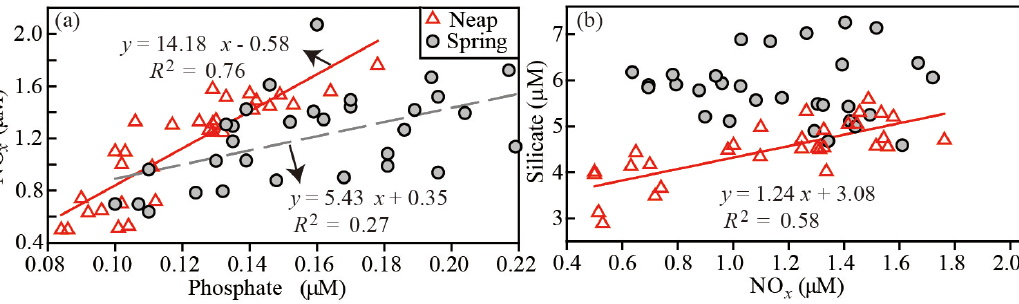
Figure 7. Concentrations of (a) NO x against phosphate and (b) silicate against NO x in the water column during the spring tide and neap tide at station CT during 6–13 February 2012.